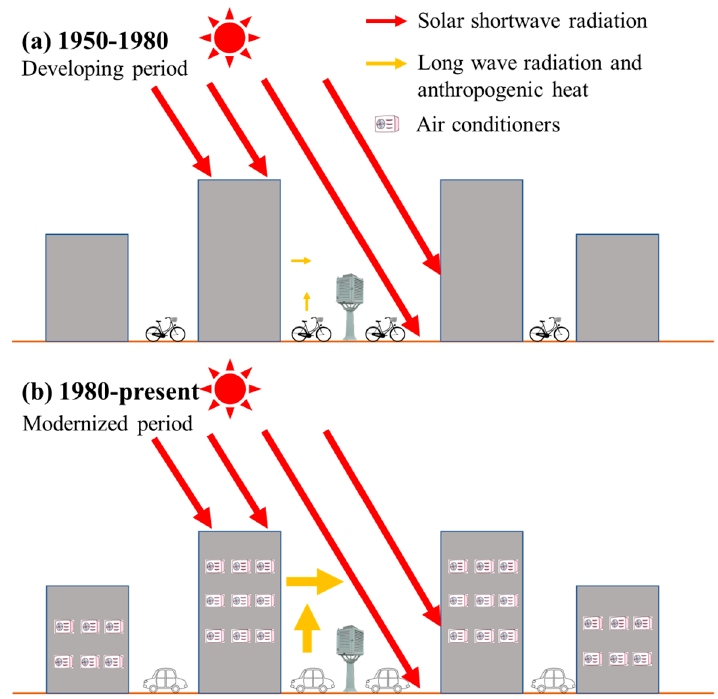
Figure 10. Physical mechanism of the evolution of the maximum temperature in Hong Kong (( a ) 1950–1980, with little anthropogenic heat; ( b ) 1980–present, with strong anthropogenic heat. The thickness of arrows indicates the strength of radiation energy).